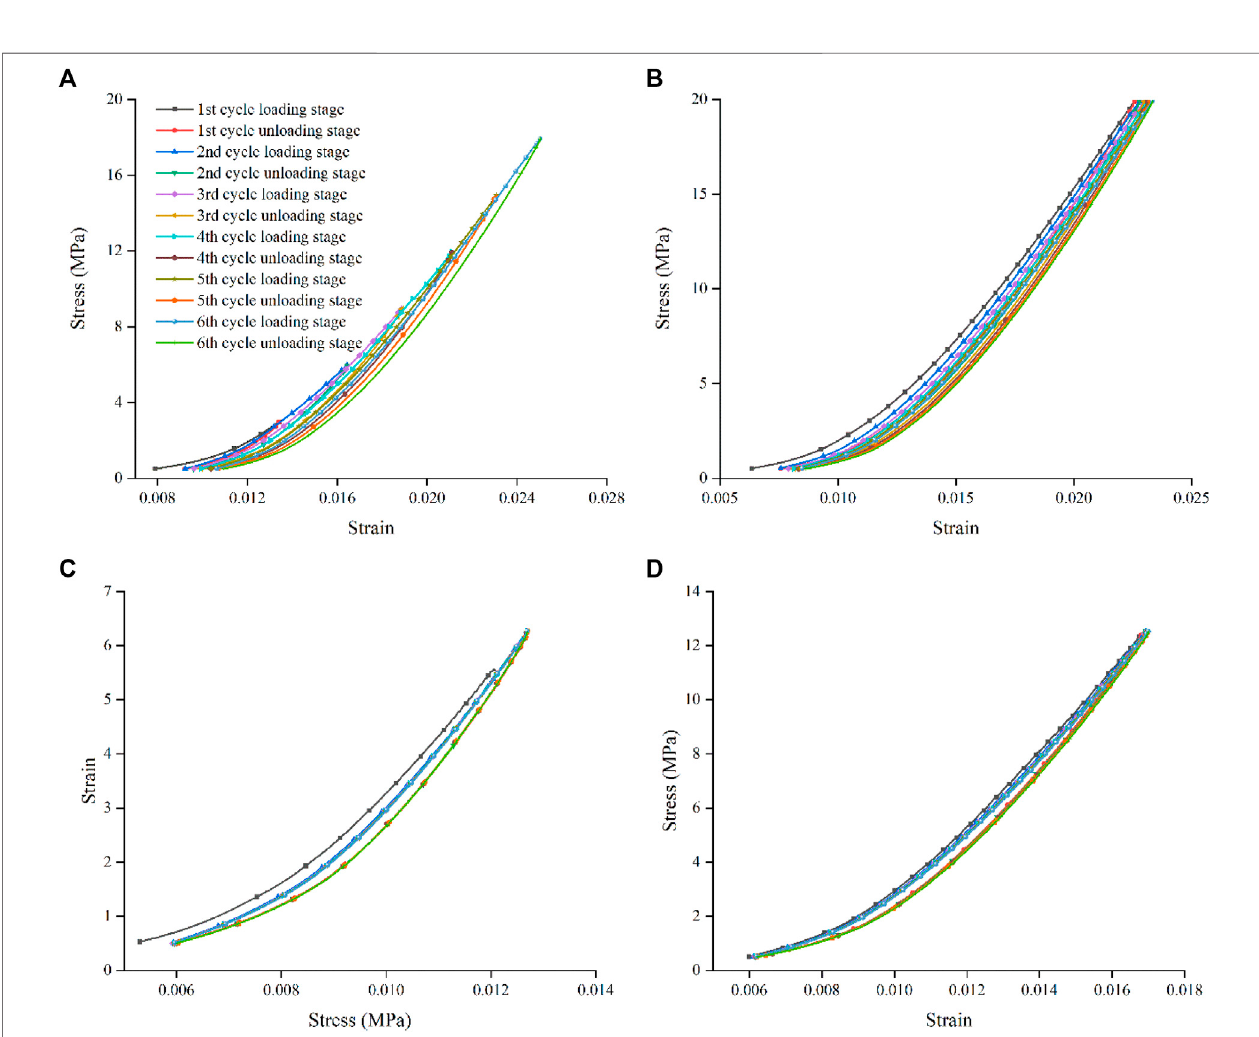
FIGURE 10 | Stress-strain curves of coal samples for different cyclic loading and unloading paths. (A) Increased amplitude cycle loading; (B) Constant amplitude cyclic loading; (C) The fi rst stage of loading in sections; (D) The second stage of loading in section.